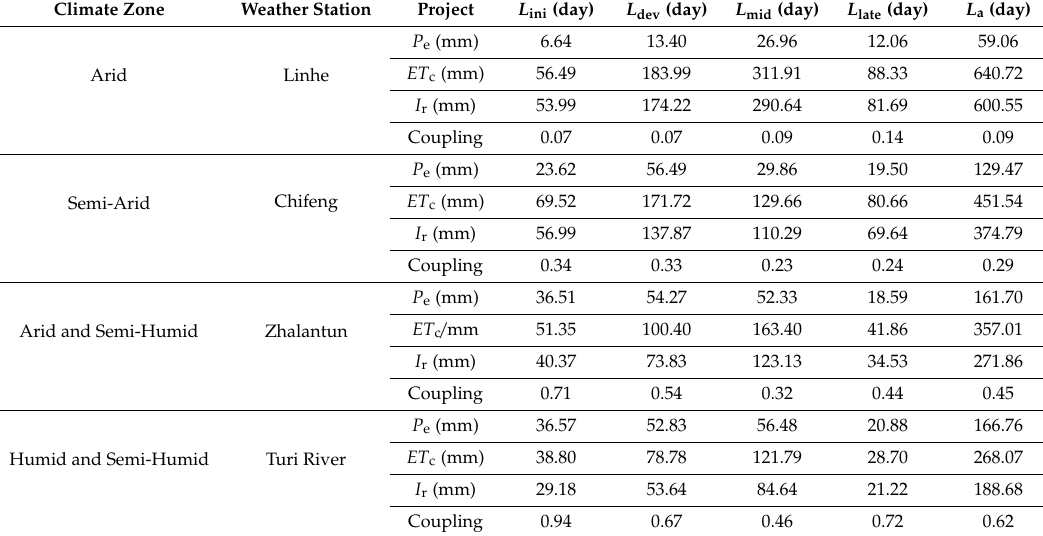
Table 2. I r , ET c , P e and their coupling degree at typical meteorological stations in di ff erent climate regions averaged over